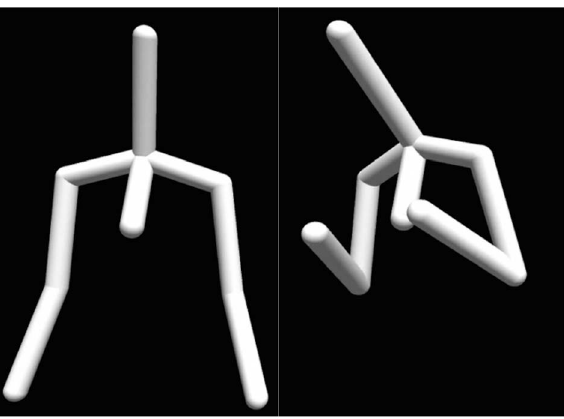
Figure 2. Stick-figure representations of human upper body used in the emotion categorisation studies [51] . Regardless of the body proportions of the actor, the motion trajectories were mapped onto a skeleton of average body size. Note that the motion capture files included in the database contain data for the full body and have the original actors’ body size and proportions.